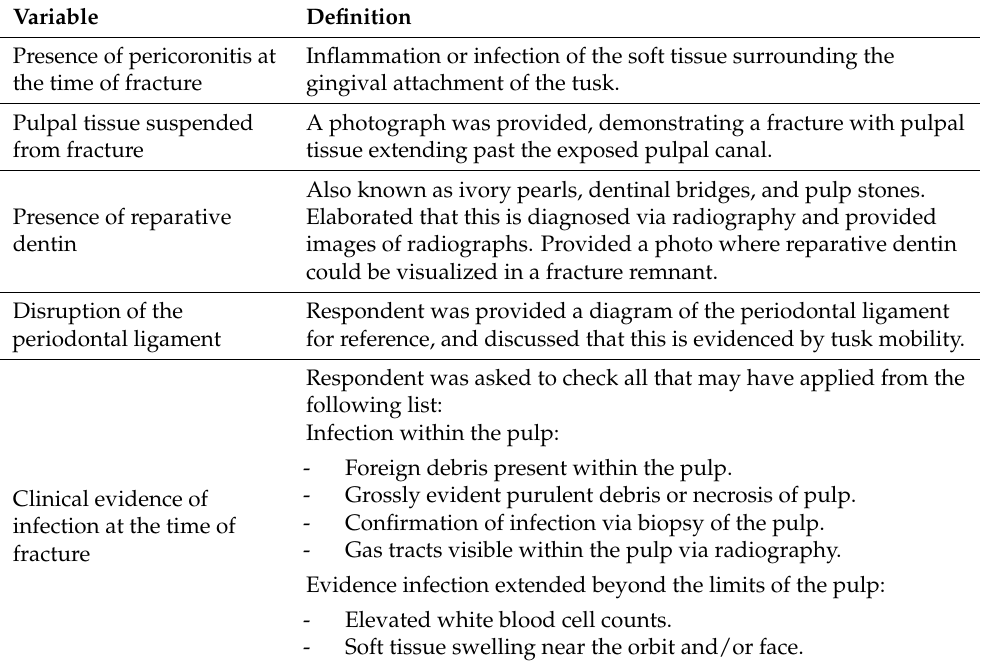
Table 1. Definitions for variables pertinent to objective 2, characteristics of tusks